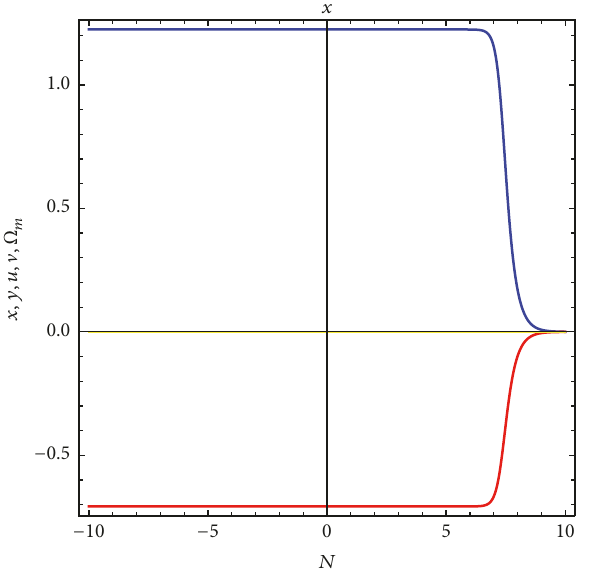
Figure 4: Plot of ( 4 ) variations of 𝑥 (blue), 𝑦 (green), 𝑢 (orange), Figure 6: Plot of ( 6 ) variations of 𝑥 (blue), 𝑦 (green), 𝑢 (orange), V (red), and Ω V (red), and Ω 𝑁 near 𝑃 𝛾 = 1 , 𝛿 = 1 , and 𝑁 near 𝑃 𝛾 = 0 , 𝛿 = 1 , and 푚 (yellow) versus 5 , for 푚 (yellow) versus 7 , for 𝜆 = −0.5 . The position corresponding to 𝑁 = 0 is the fixed point 𝜆 = −0.5 . The position corresponding to 𝑁 = 0 is the fixed point under consideration. under consideration.